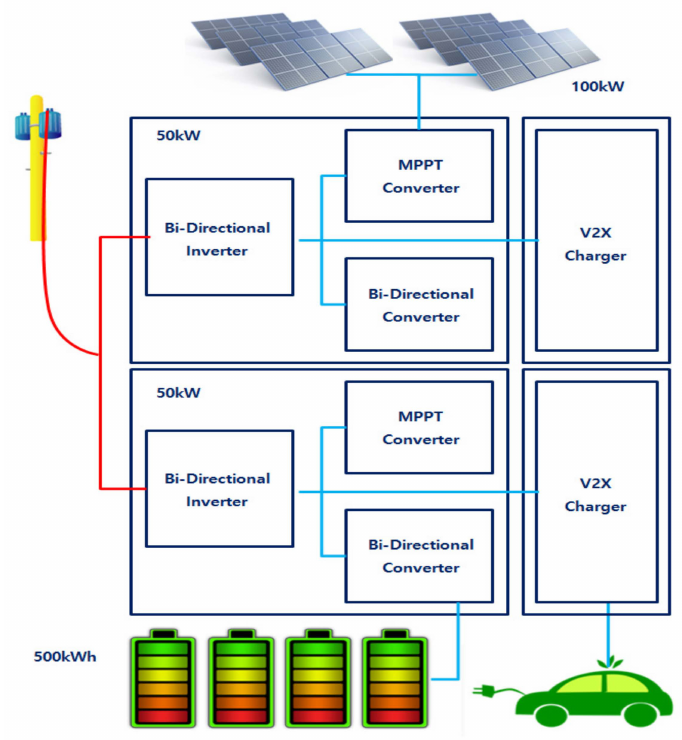
Figure 6. System diagram for V2X field